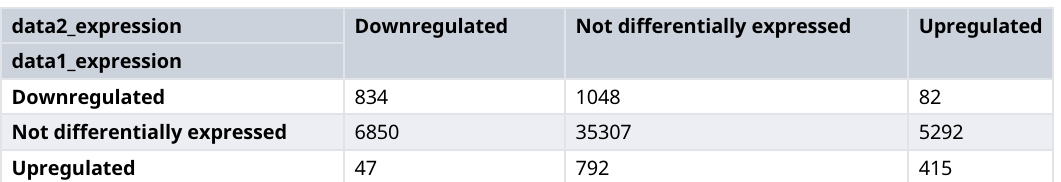
Table 1. Table summarizing the numbers of gene